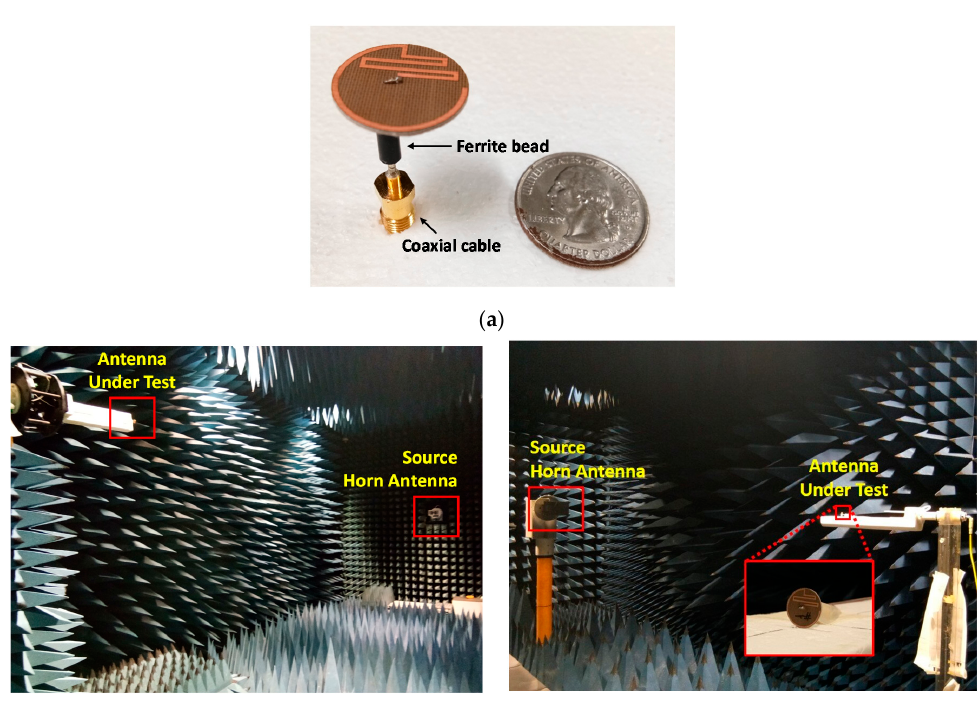
Figure 7. Photos of the built antenna and the radiation performance measurement setup. ( a ) The built prototype of the proposed antenna. ( b ) The anechoic chamber for the radiation pattern measurement. ( c ) The anechoic chamber for the three-dimensional gain and efficiency measurement.